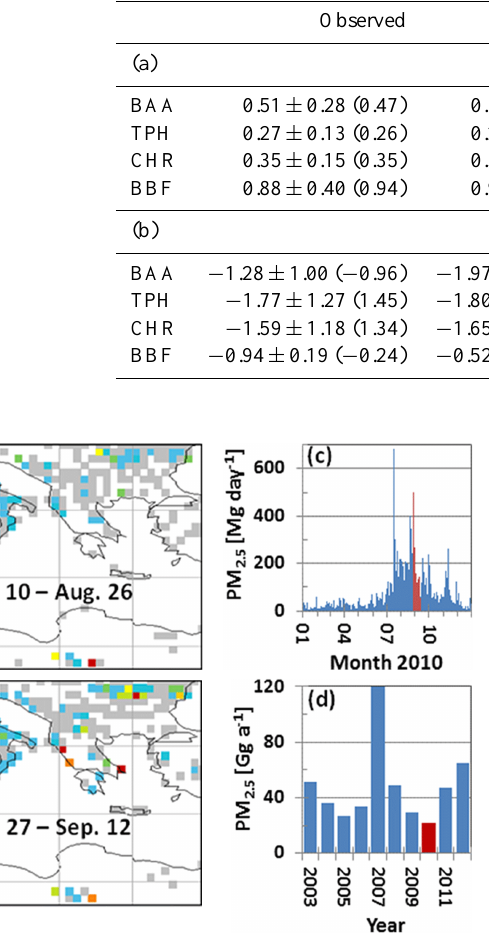
Figure 2. Spatial pattern of fire-related PM 2 . 5 emissions (Global Fire Assimilation System, GFASv1.0; Kaiser et al., 2012) for the eastern Mediterranean (28–45 ◦ N/8–30 ◦ E), (a) time integral of 10– 26 August, (b) time integral of 27 August–12 September 2010, given as sum over each period in metres per milligram. Areas with no observed fire activity are displayed in white. Temporal pattern of domain-integrated (c) daily total PM 2 . 5 emissions over 2010 (c) and yearly total PM 2 . 5 emissions over 2003 to 2012. Labelled in red is (c) the the period of the Urania cruise (27 August–11 September 2010) and (d) the year